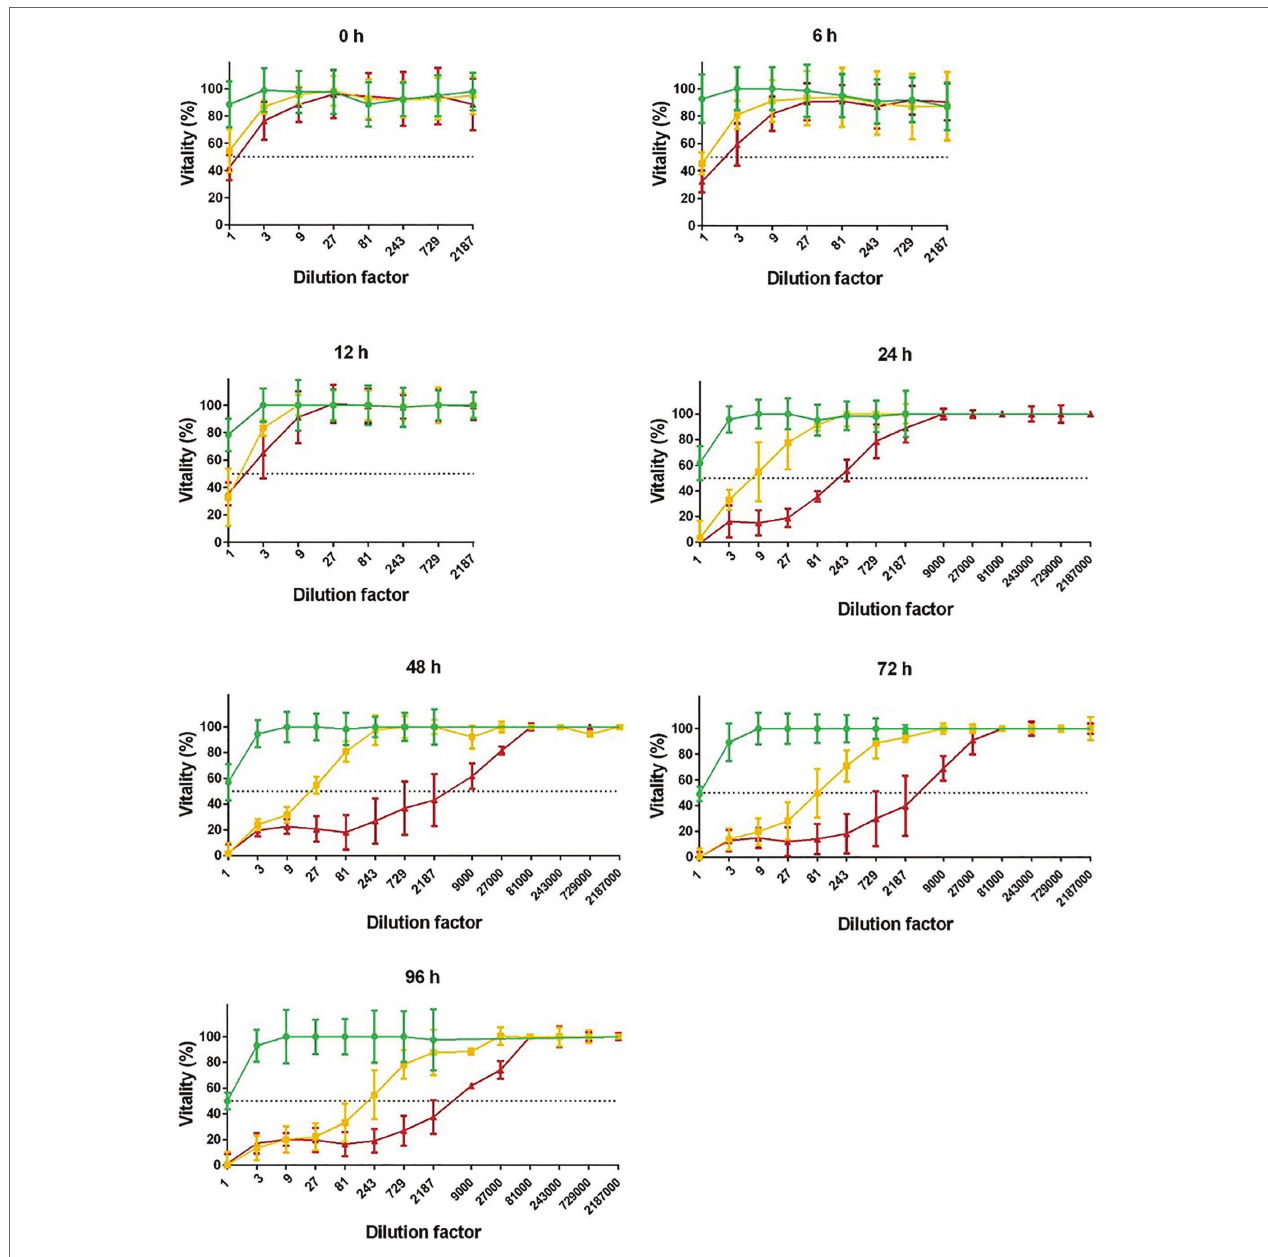
FIGURE 1 | Cytotoxicity of different Clostridioides difficile ribotypes. Conditioned media (BHI) of RT010 (green), RT014 (yellow), and RT027 (red) C. difficile strains were harvested after 0, 6, 12, 24, 48, 72, and 96 h anaerobic culture. Cytotoxicity was tested in serial dilution with Vero cells in 96-well cell culture wells. Cytotoxicity 50% (CD50%) titers were calculated (dotted lines). Non-toxigenic RT010 served as negative control. Unspecific toxicity of undiluted media (titer <1:9) was not